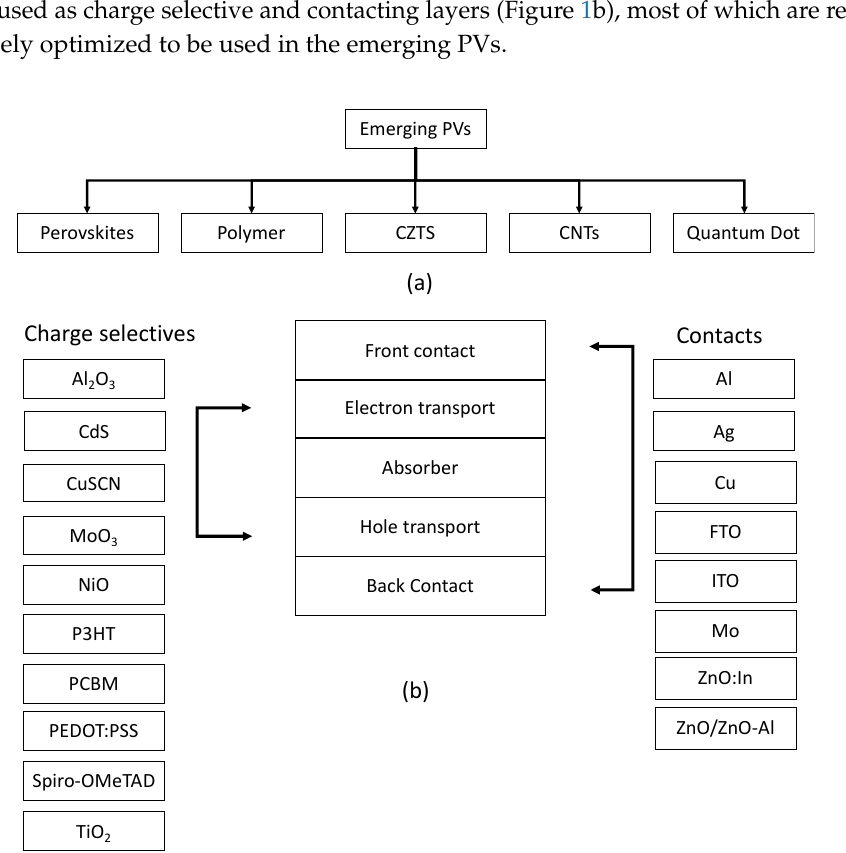
Figure 1. Emerging photovoltaic (PV) types ( a ) and the cell structure of PV cells ( b ). The color coding shows the alternative materials that can be used in emerging PV devices. P3HT stands for poly (3-hexylthiophene-2,5-diyl), PCBM is for phenyl-C61-butyric acid methyl ester and PEDOT:PSS is for poly polystyrene sulfonate.